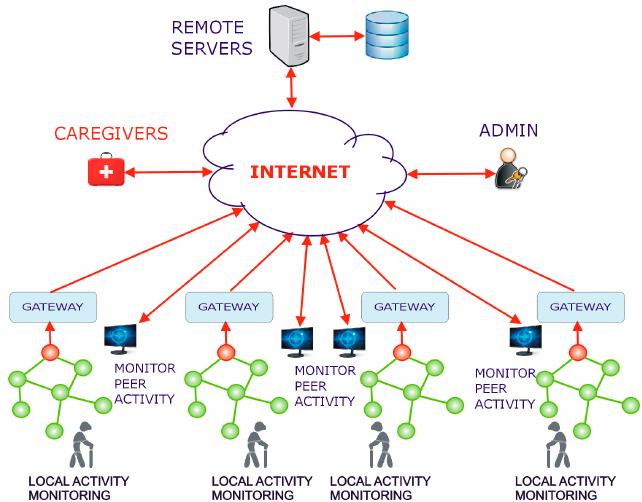
Figure 16. The structure of a network of individual monitoring systems that allows peer to peer monitoring.